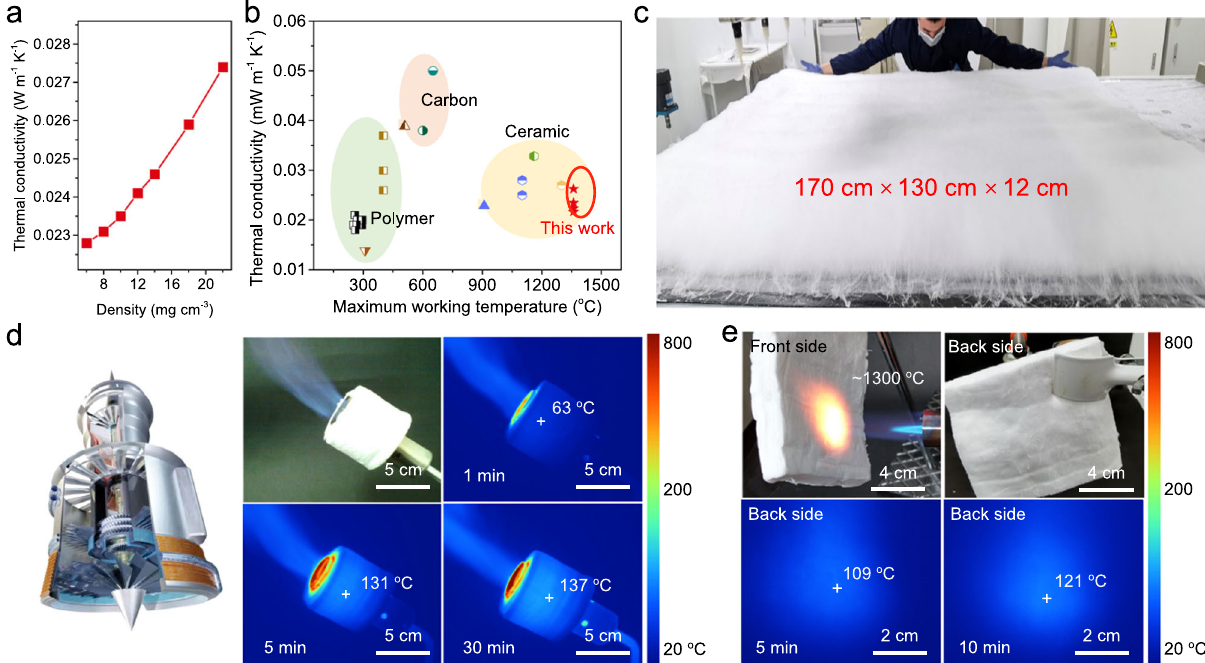
Fig. 4 Thermal insulation properties of ICCAs. a Thermal conductivity of the ICCAs as a function of density. b Comparison of the thermal conductivity and maximum working temperature among different aerogel-like materials. c Optical image of a large-size precursor ICCA. d Infrared images of a butane nozzle protected by ICCAs during a 30 min heating process, the colored scale bar shows the temperature. e Optical and infrared images of ICCAs exposed to a butane blowtorch for 10